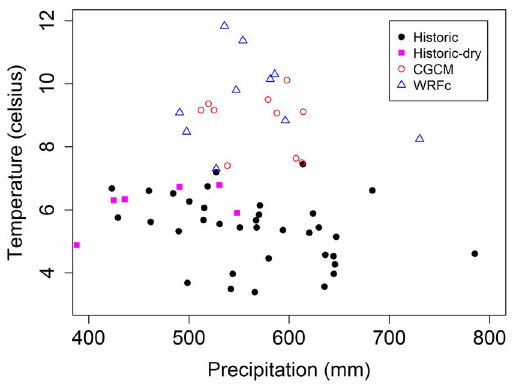
Figure 2. Total precipitation versus average temperature by ‘‘bird year’’ (June of year x-1 to May of year x) for the study area (see Figure 1) for the time periods used to train species distribution models and project future distributions. Historic points showed the years and locations from 1971–2011 used to train the species distribution models with six years withheld. The six years were a dry period from 1987–1992 shown as ‘historic-dry’. CGCM and WRFc show two sets of climate projections for the ten year period 2040-